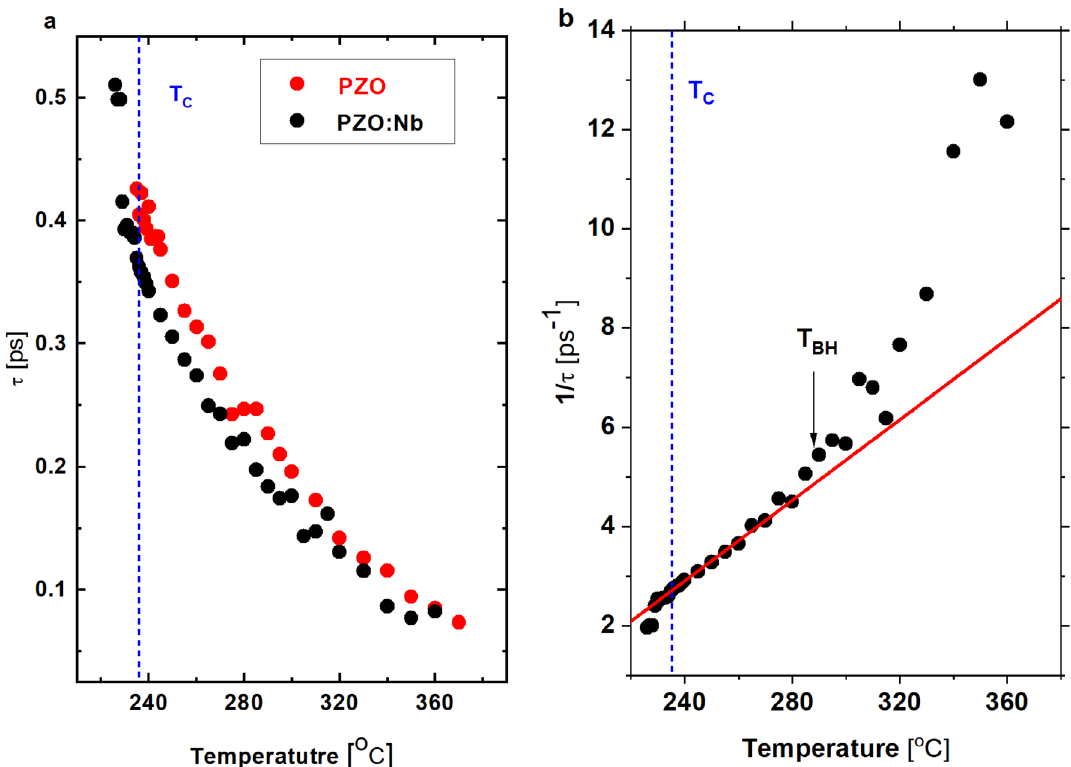
Figure 5. ( a ) Temperature dependence of relaxation time, and ( b ) inverse relaxation time derived from the abnormal changes in the LA1 mode frequency and its